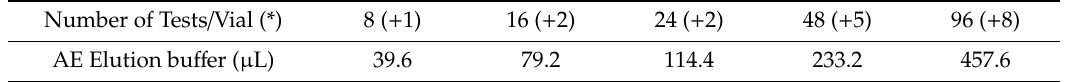
Table 3. Vial regeneration according to the number of tests per